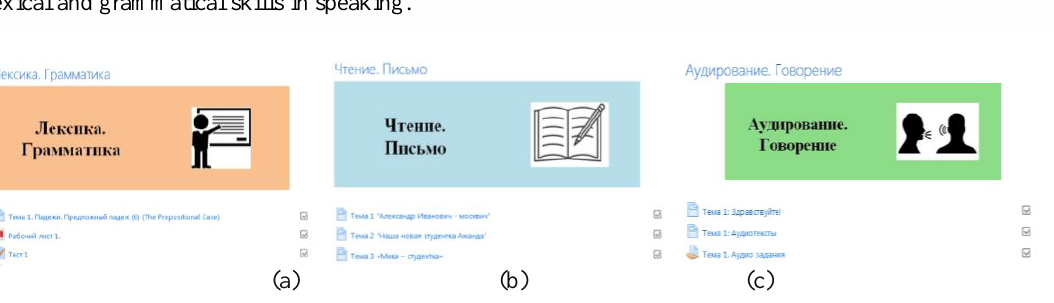
Figure 1. (a) & (b) & (c) Blocks in the course’s RFL module on Moodle platform